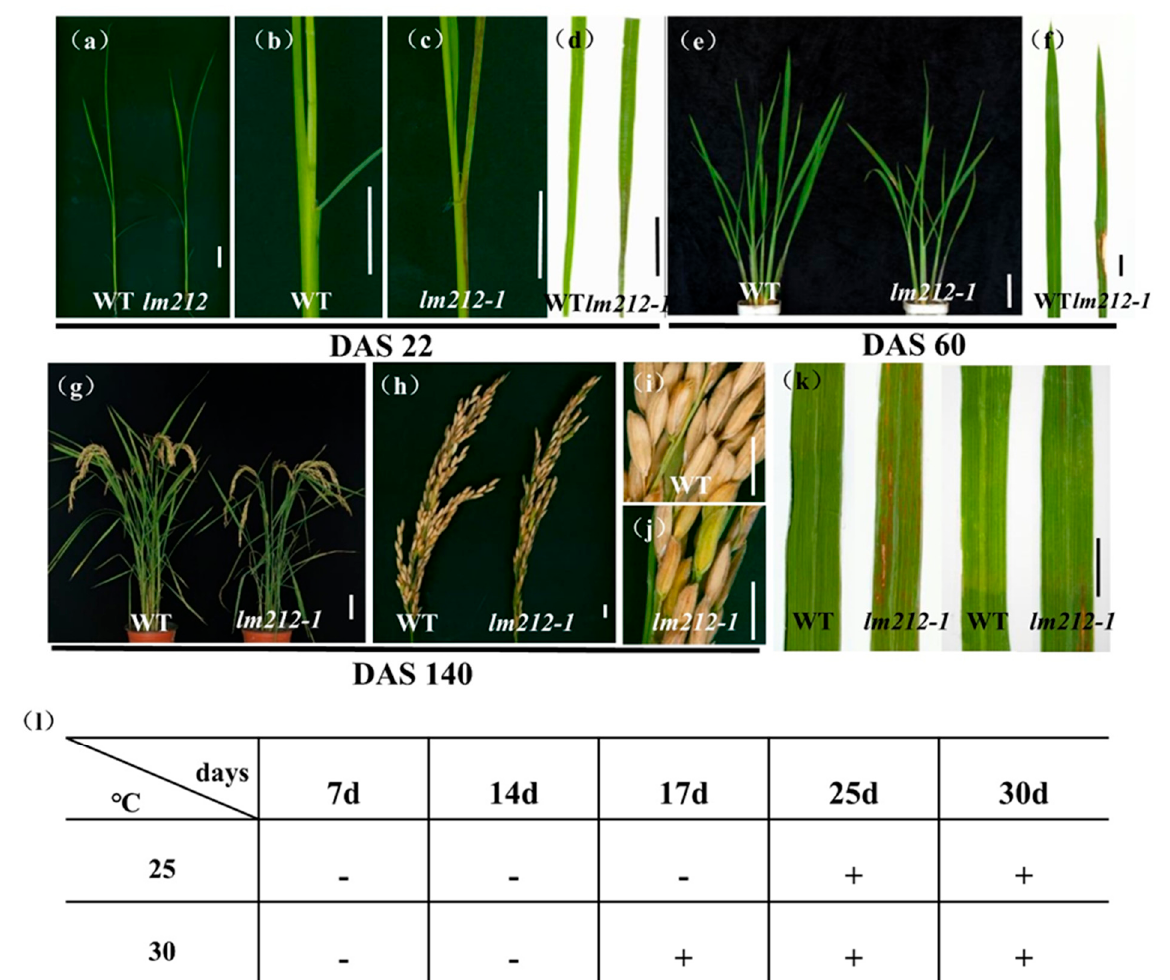
Figure 1. Phenotypes of WT and the lm212-1 mutant. ( a ) Plants at the seedling stage (DAS22). ( b , c ) Stem and leaf sheath at the seedling stage (DAS22). ( d ) Leaves at the seedling stage (DAS22). ( e ) Plants at the tillering stage (DAS60). ( f ) Leaves at the tillering stage (DAS60). ( g ) Plants at the mature stage (DAS140). ( h – j ) Phenotypes of panicle at the mature stage (DAS140). ( k ) Leaf blades of WT and lm212-1 at the tillering stage. ( l ) Temperature treatment assay of the lm212-1 mutant at 25 ◦ C or 30 ◦ C. +, lesions appear; − , normal leaves. Scale bars ( a – d , f , j , k ), 1 cm; Scale bars ( e , g ), 10